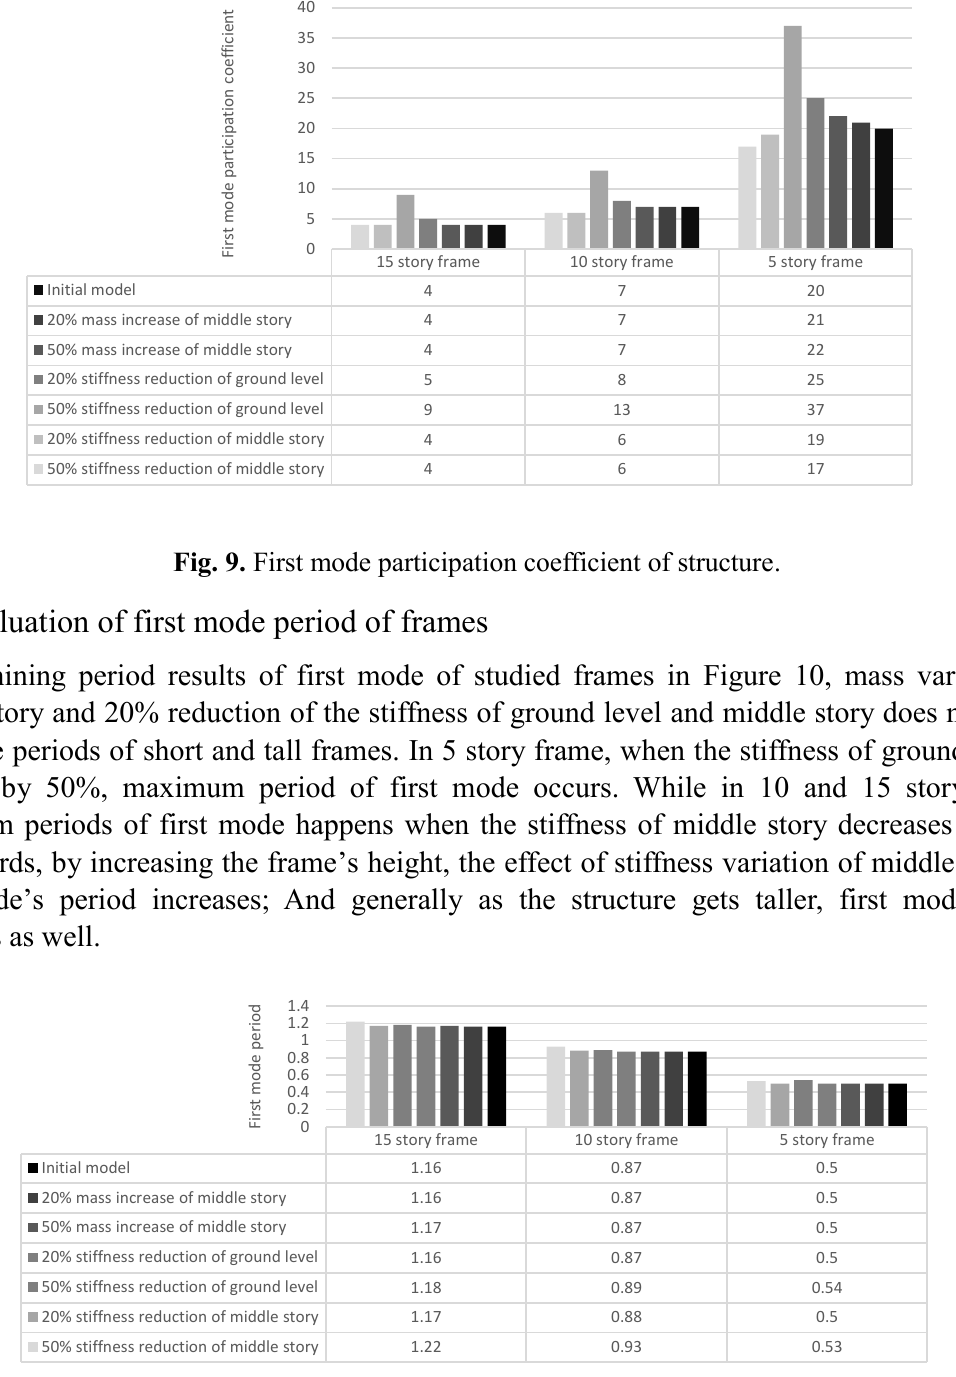
Fig. 10. First mode period of 5, 10 and 15 story frame story